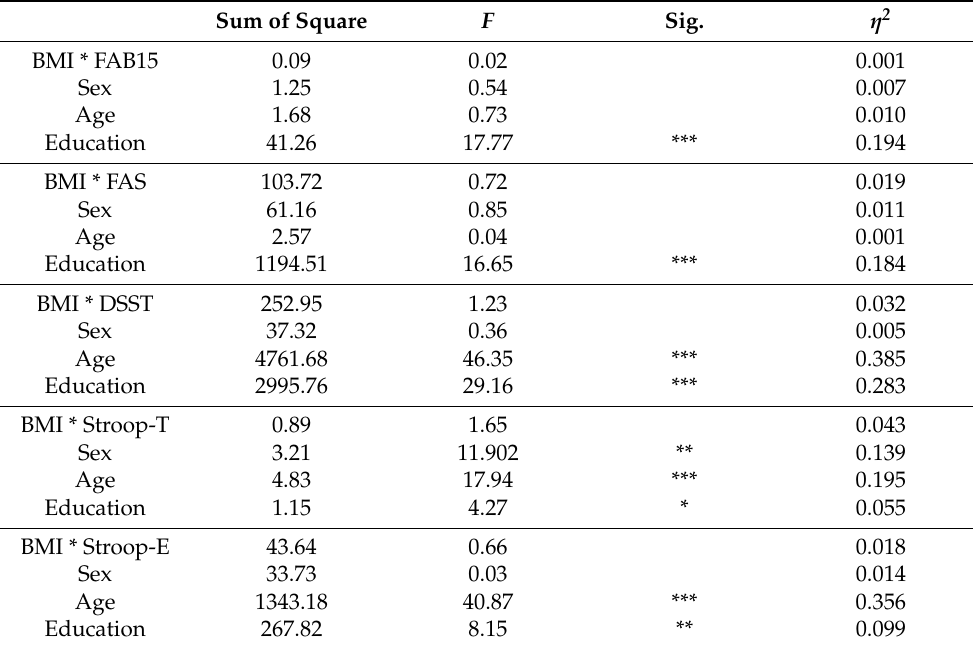
Table 2. Results of Univariate Analyses of